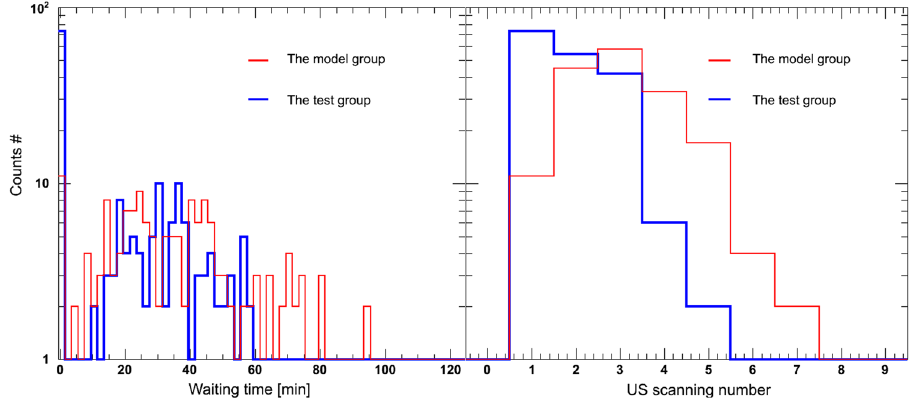
Figure 4. The histogram of waiting time and US scanning number of patients during RT